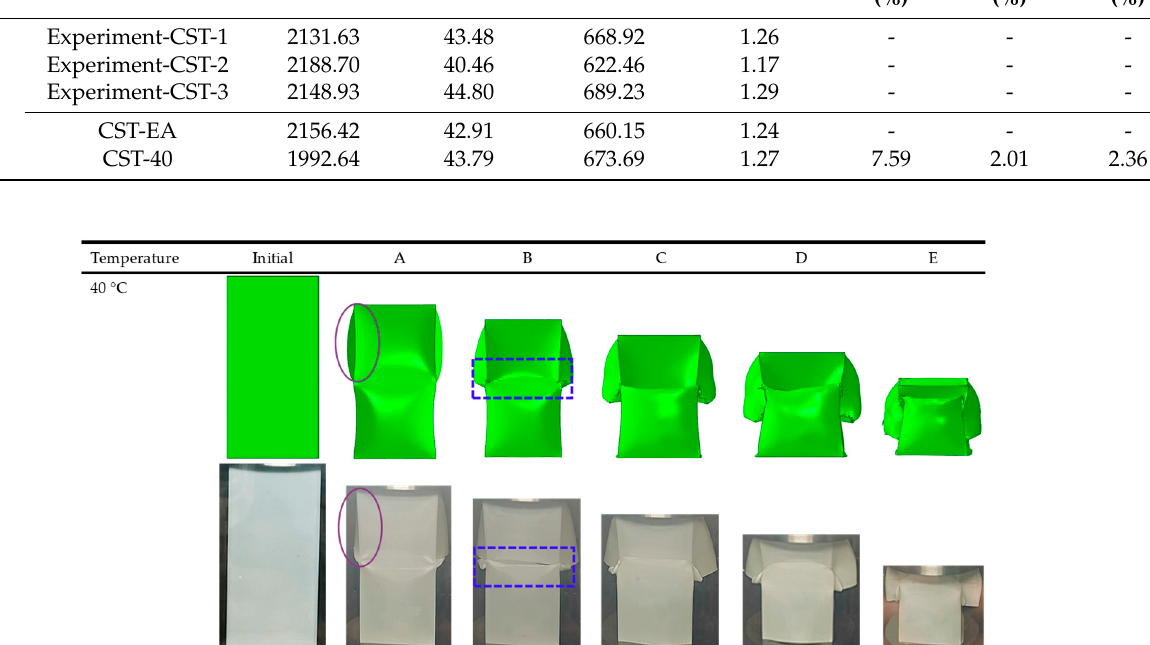
Figure 7. At 40 °C , the experimental and simulation comparison results of the deformation modes of